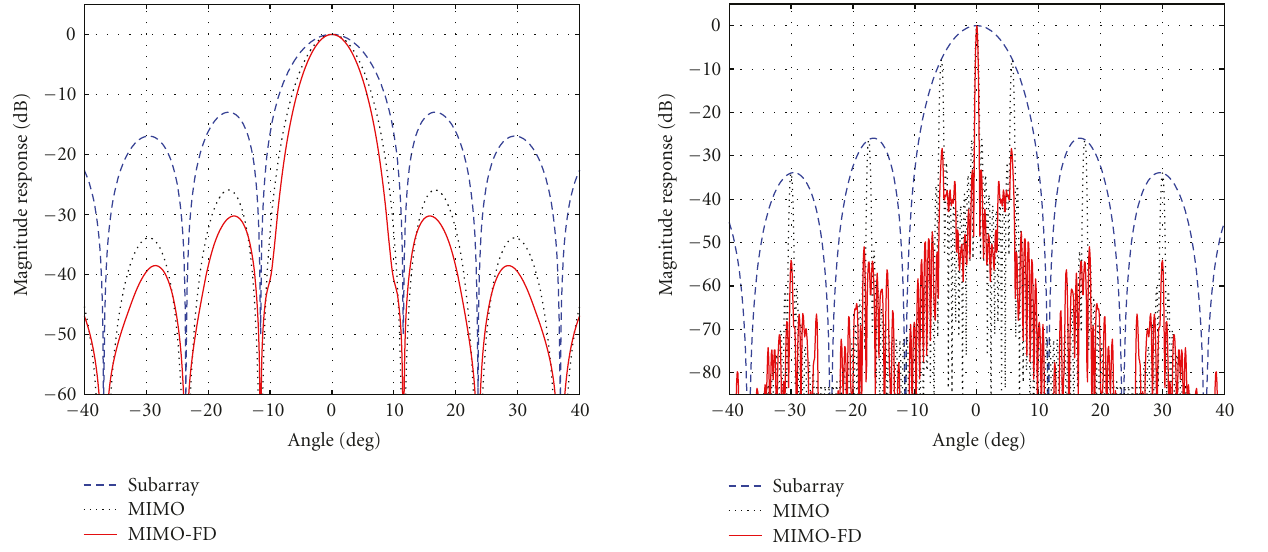
Figure 5: Beam pattern for MIMO and MIMO-FD arrays with half a wavelength spacing.